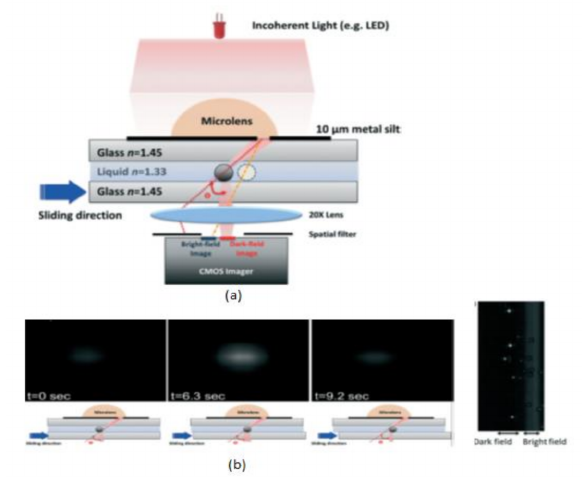
Figure 45. ( a ) Scattering image-based cytometer ( b ) Images of traveling bead over the sensing area in different time intervals from dark field to bright field. Figure adapted with permission from [51], Royal Society of Chemistry, 2014.